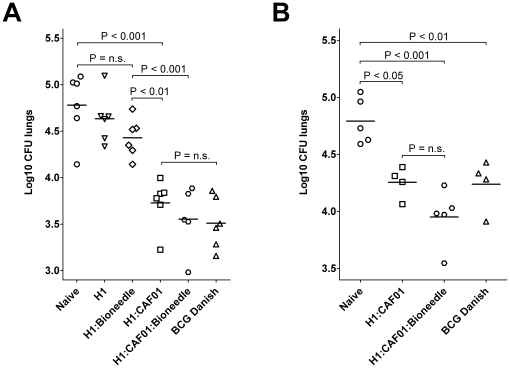
TB bacterial burden in mice upon vaccination.Mice were challenged by the aerosol route with virulent M. tuberculosis A) 6 weeks and B) 52 weeks after the last immunization. Six weeks post challenge, mice were sacrificed and the bacterial burden (CFU) measured in the lungs (expressed as log10 CFU). As a positive control group, a group of mice received a BCG vaccination ten weeks before challenge.